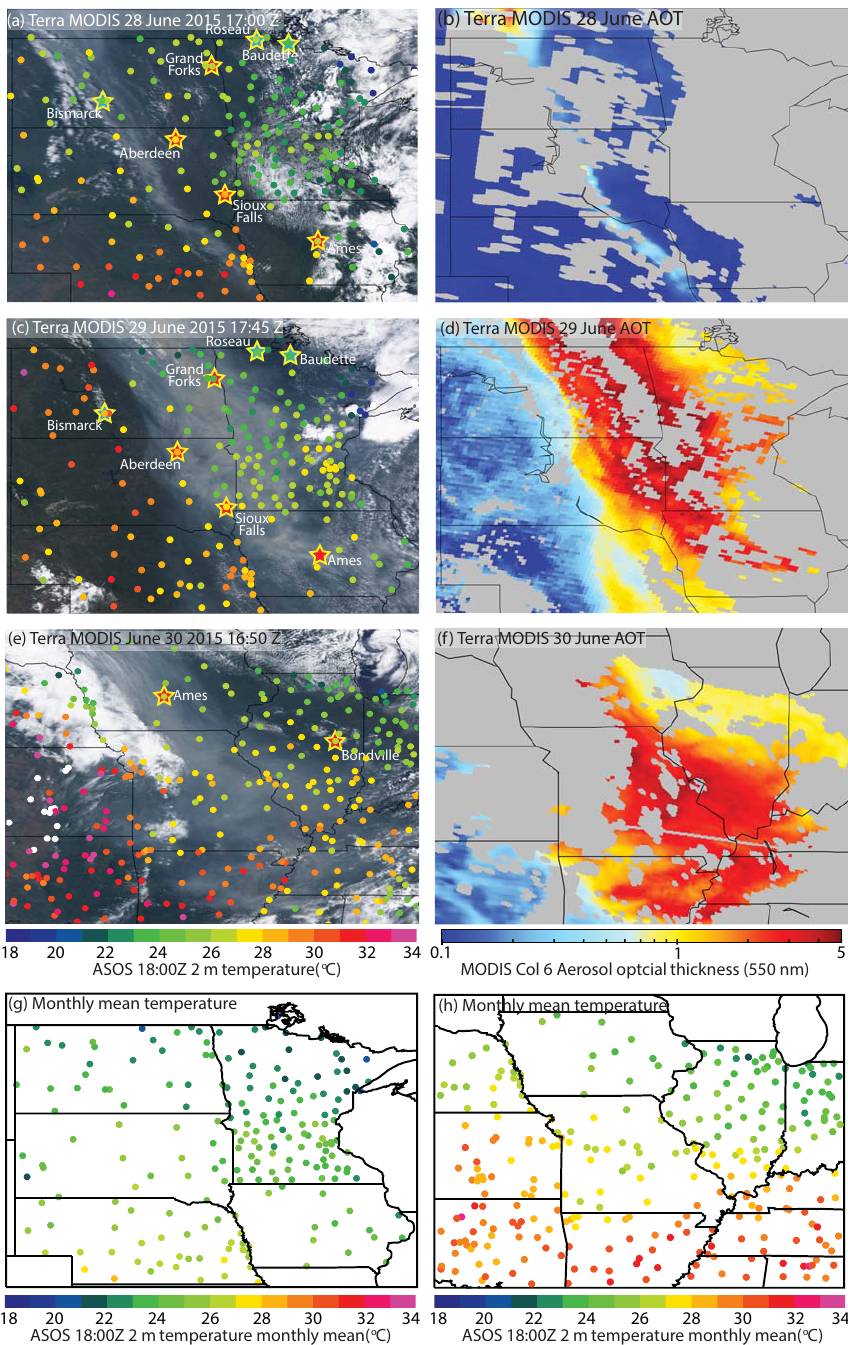
Figure 3. (a, c, e) True color images of a smoke event over the Midwestern United States (28, 29, 30 June 2015, respectively), constructed using the Level 1b Terra MODIS data. The ASOS 18:00Z temperatures are overlaid. Core evaluation sites are labeled; (b, d, f) corresponding 550nm aerosol optical thickness from the Collection 6 Terra MODIS aerosol products; (g, h) mean 18:00Z station temperature ± 15 days of the event (15 June–14 July 2015. 29 June data are excluded for constructing Fig. 3g, and 30 June data are excluded for constructing Fig.